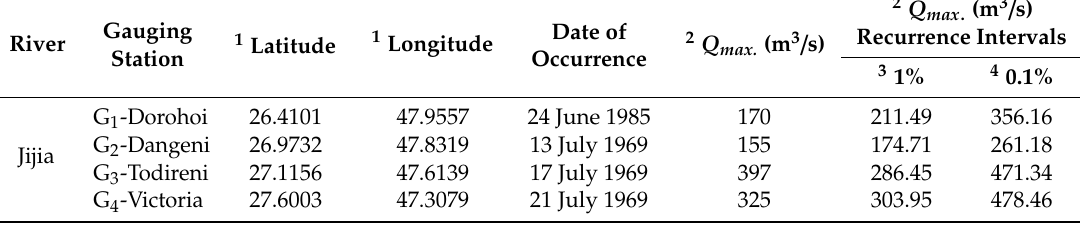
Table 1. The Q max (m 3 / s) flow rates and the recurrence intervals probabilities estimated using the Weibull and Pearson type III distribution curve for each gauging station (G n ) on the Jijia River between 1969 and